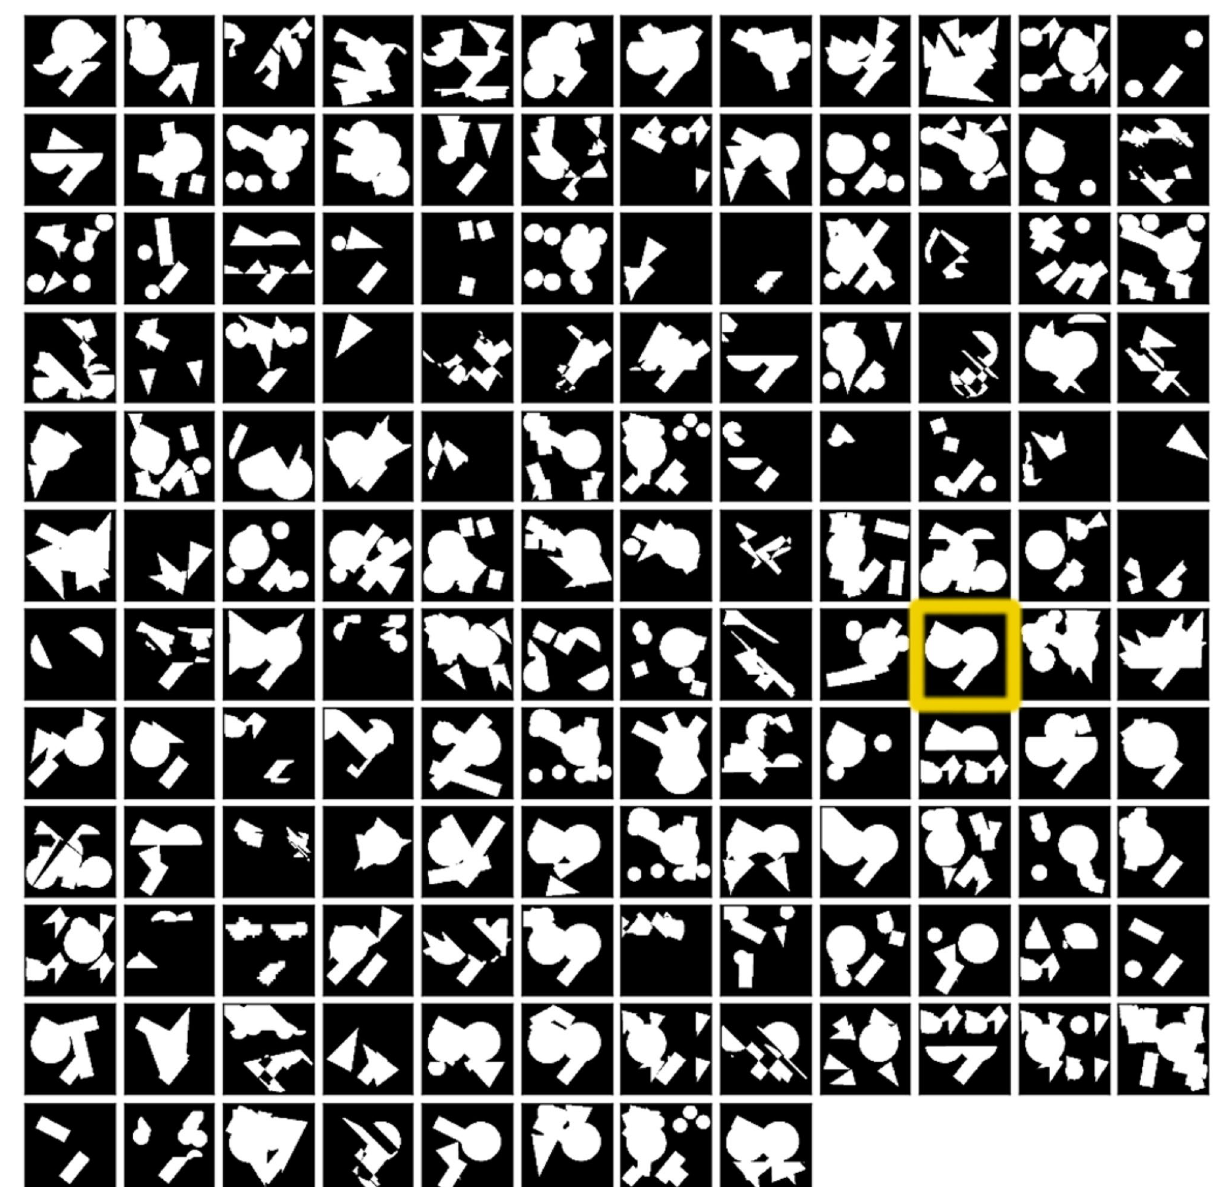
Figure 5. Progeny of the ALP hit surface from the initial screening. Parent surface is enhanced with a yellow 280 × 280 pixels. We multiplied every 100 × 100 pattern 4 times to create a pattern with size 200 × 200. 280 × 280 patterns were excluded from our analysis as cropping them to the size of 200 × 200 would alter initial design significantly as not only shape of the pillars is important but also spacing between them. We used the t-SNE visualization algorithm, which applies nonlinear transformations to map multidimensional relations in a 2D plot, to compare these multidimensional data. t-SNE visualization was performed on the first 5000 PCs computed on images of the topographical features (pixel-based representation). Figure 7B clearly shows that some topographies from the original chip create a distinct cluster. Interestingly, small features occupy the left lower corner of the plot, and there is a large cluster at the top right corner of the plot (data not shown). The blank surface is in the lower left corner of the plot. Based on our previous research 13 these topographies gener- ally do not induce high levels of ALP. Interestingly, the t-SNE plot created similar clusters regardless of whether pixel or feature based genes were used (data not shown). Both topographies created by pixel and pattern design spanned homogeneously across the plot. However, some topographies created very dense areas, enriched with pixel-based topographies and sparse with primitive-based representations, and not represented by parents. Future work will involve in vitro biological validation of the fabricated surfaces and the use of evolutionary methods to optimize topographies for more useful or realistic biological end points such as cell attachment, pro- liferation, and differentiation fate. Additionally, finding a surface inducing higher ALP expression, will validate